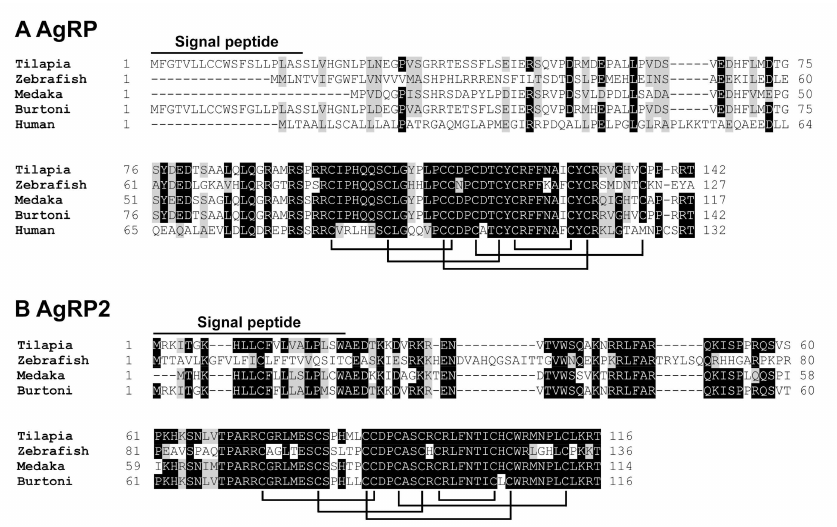
Figure 4. Alignment of AgRP and AgRP2 in teleosts. ( A ) Amino acid alignment of tilapia AgRP (MT740813) with that of zebrafish (NP_001314941), Japanese medaka (FAA00766.1), Burton’s mouthbrooder (XP_005929271), and humans (NP_001663). ( B ) Amino acid alignment of tilapia AgRP2 (MT740814) with that of zebrafish (NP_001258220), Japanese medaka (XP_004078940), and Burton’s mouthbrooder (XP_005939107). Signal peptides are marked by horizontal lines. Lines joining cysteine residues indicate the intra-molecular disulfide